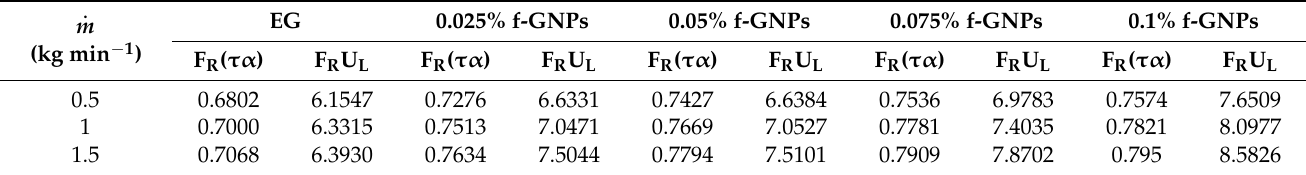
Table 2. Heat absorbed and heat removal factors at a different flow rate for the EG-based f-GNPs nanofluids. . m